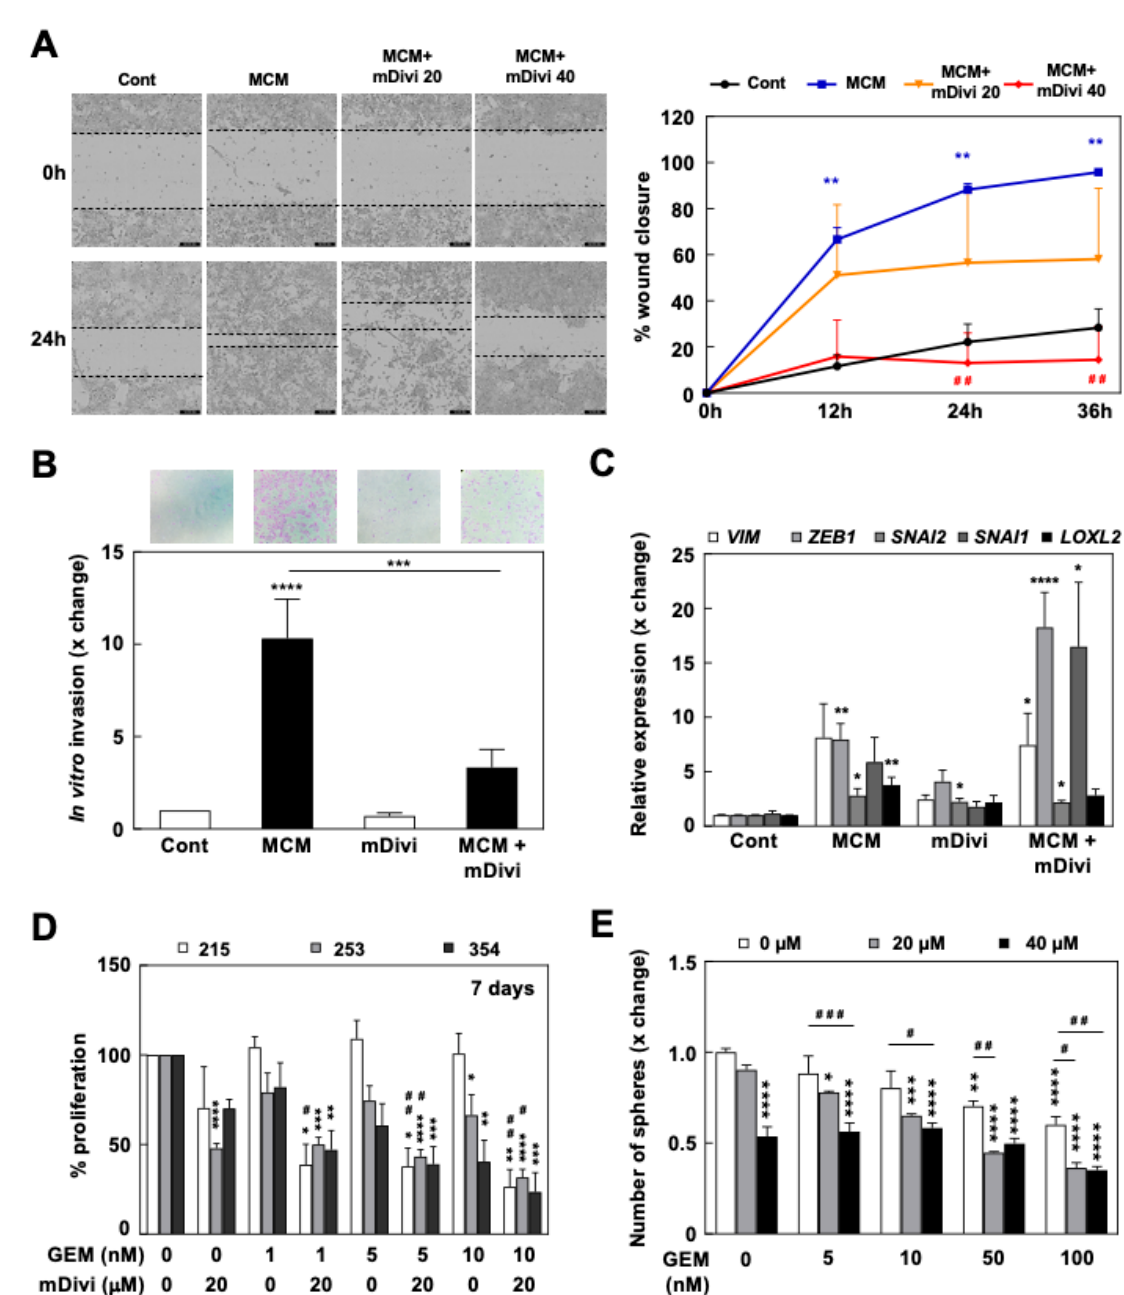
Figure 6. mDivi-1 treatment inhibits invasiveness and sensitizes PDAC cells to Gemcitabine. ( A – C ) In total, 354 cells were pretreated for 48 h with M2-polarized macrophage-conditioned medium (MCM) to induce EMT in the presence or absence of mDivi-1. ( A ) Effects of mDivi-1 treatment on migration via wound healing assay visualized in an IncuCyte ® at the indicated times and doses. Left, representative pictures at 0 and 24 h after scratch. Right, quantification ( n = 3). ( B ) Invasion assay in Boyden’s chamber of MCM-treated 354 cells after treatment with mDivi-1 40 µM. ( n = 6). Top, representative images of crystal violet stained cells after 24 h of migration. Bottom, quantification. ( C ) Relative EMT gene expression (pooled data of 215 and 354 cells, n = 4). ( D ) Evaluation of the proliferation rate of the indicated PDX cultures after seven days of treatment with Gemcitabine (nM) with or without 40 µM mDivi-1 ( n = 3–7). ( E ) Sphere formation ability in the presence of Gemcitabine (nM) and/or mDivi-1 in 185 cells ( n = 4). * vs. control (DMSO treatment) condition, * p < 0.05, ** p < 0.01, *** p < 0.001, **** p < 0.0001; # vs. MCM or Gemcitabine treatment alone, # p < 0.05, ## p < 0.01, ### p < 0.001. ANOVA with Bonferroni post-test. Data shown in the figure represent averages ± S.E.M. Controls set as 1 or 100% for fold